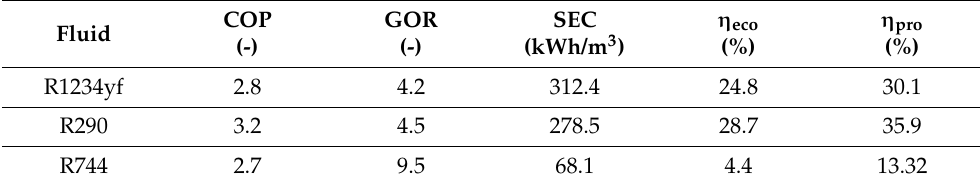
Table 13. Comparison of heat pumps for simultaneous cooling and desalination operating with HFO R1234yf, propane and CO 2.